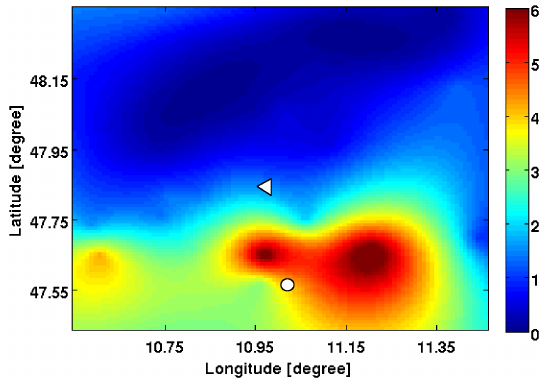
Fig. 10: Interpolated rainfall field [mm/h] derived from the Fig. 10. Interpolated rainfall field [mmh − 1 ] derived from the ob- observed precipitation values on 14/07/2008 (13:00). The served precipitation values on 14 July 2008 (13:00). The observa- observations from the 31 gauge stations in the radar do- tions from the 31 gauge stations in the radar domain are interpolated main are interpolated by application of an Ordinary Krig- by application of an ordinary kriging approach. The position of Ho- ing approach. The position of Hohenpeissenberg (Garmisch- henpeissenberg (Garmisch-Partenkirchen) is indicated by a white Partenkirchen) is indicated by a white triangle (circle). triangle